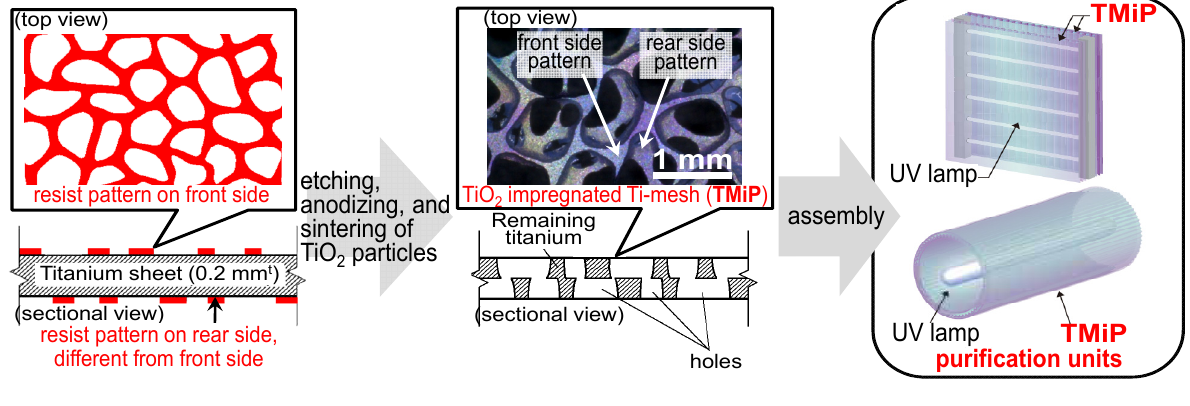
Figure 1. Fabrication method of TiO nanoparticles modified titanium mesh (TMiP™). 2 Reproduced with permission from Ochiai et al . [10], Catalysis Science and Technology; published by RSC Publishing,